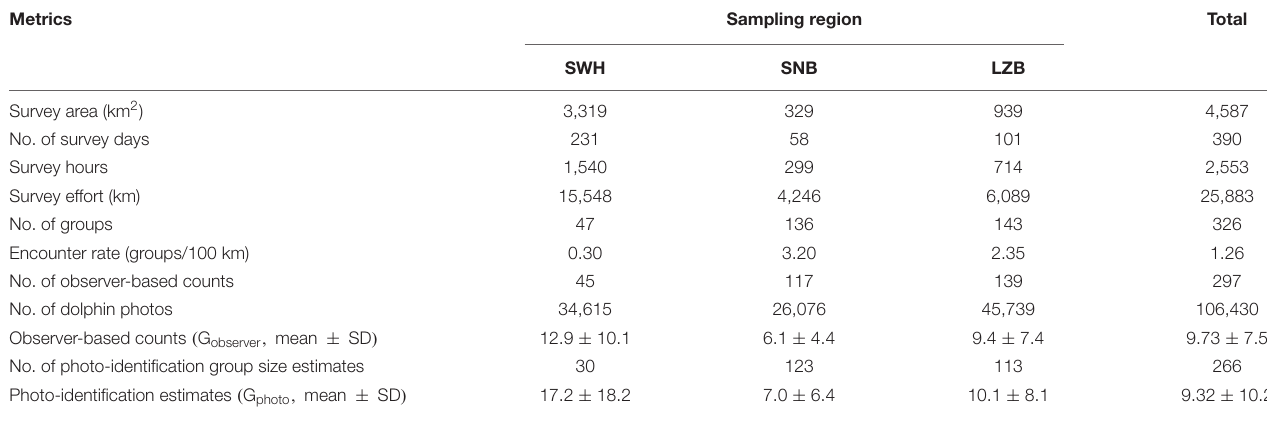
TABLE 1 | Summary of survey information on Indo-Pacific humpback dolphins ( Sousa chinensis ) in the waters southwest off Hainan Island (SWH), Sanniang Bay (SNB), and Leizhou Bay (LZB). Metrics Sampling